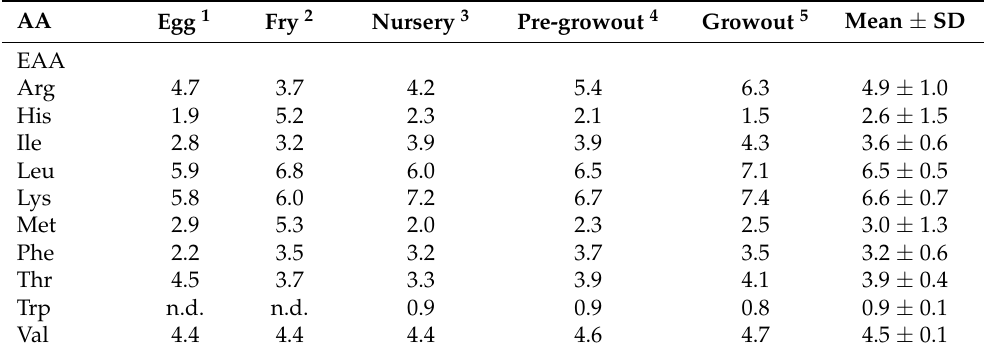
Table 1. Amino acid profile (g/100 crude protein) of eggs and whole bodies of Nile